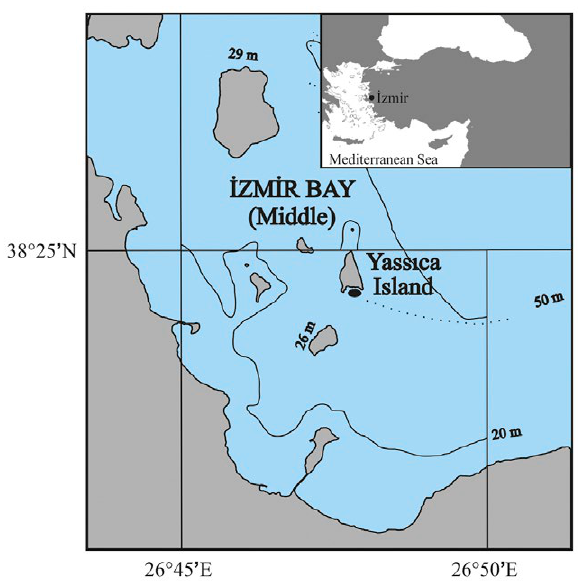
Fig. 1. – The experimental area, off İ zmir Bay. The dotted line and filled ellipse show the trawling route and cage location,